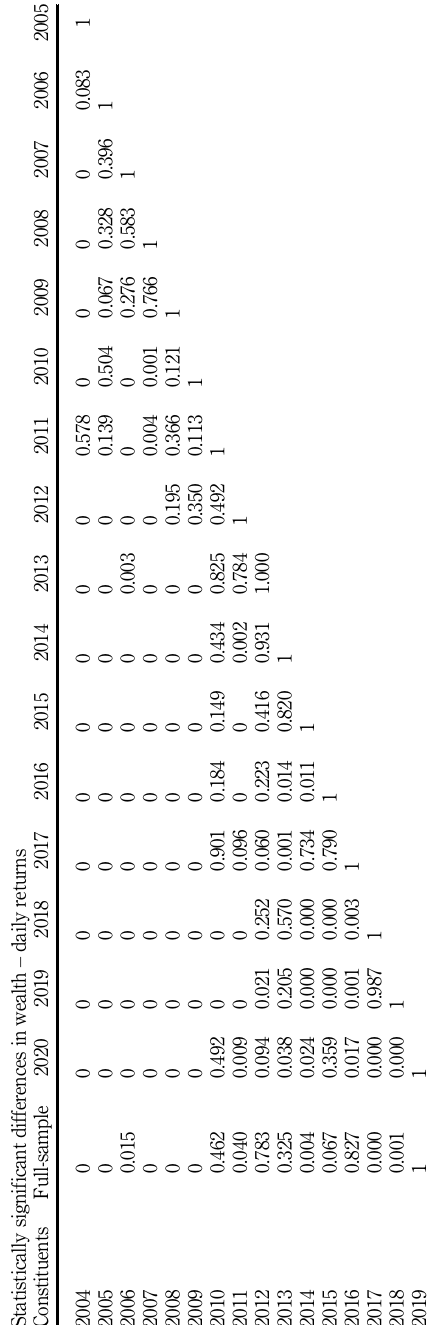
Table 2. p -valueresultsof t